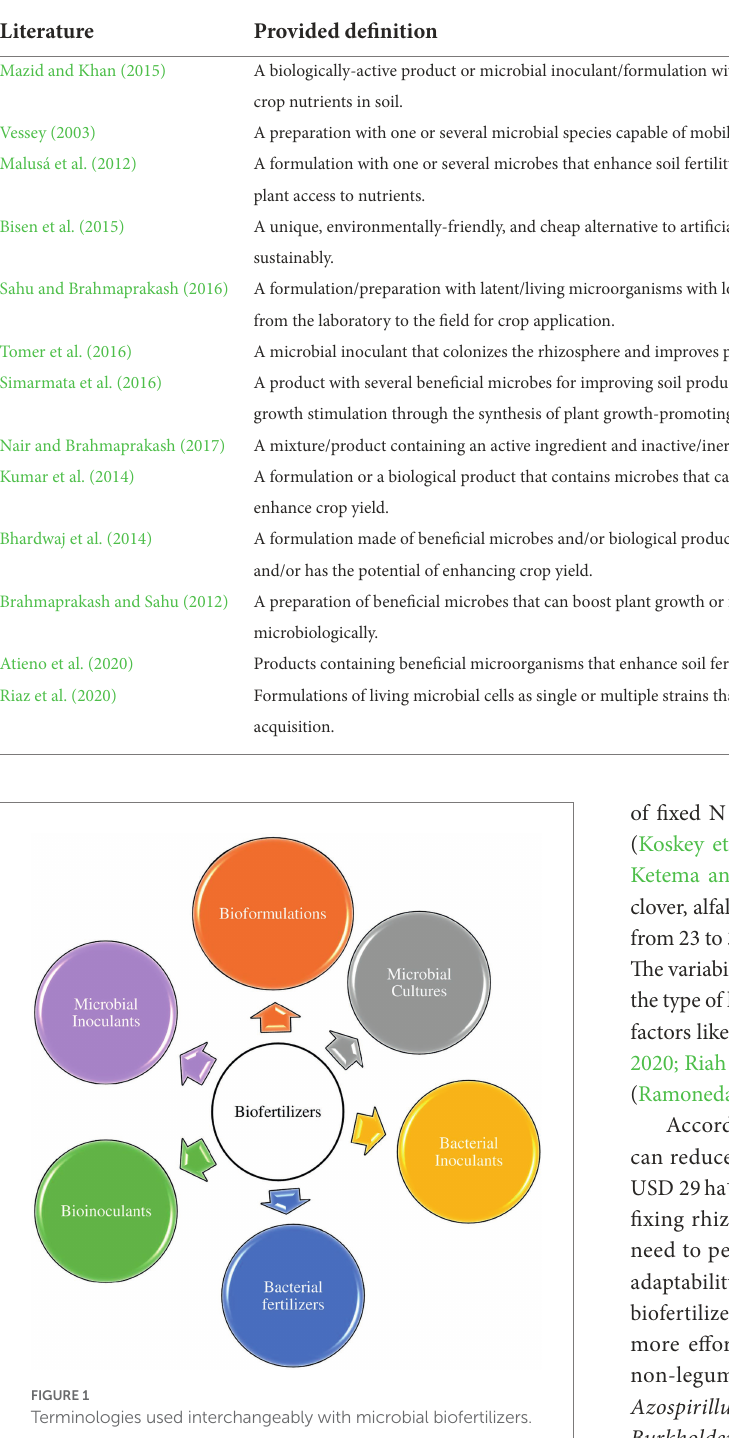
TABLE 1 Common definitions of biofertilizers from different literature.